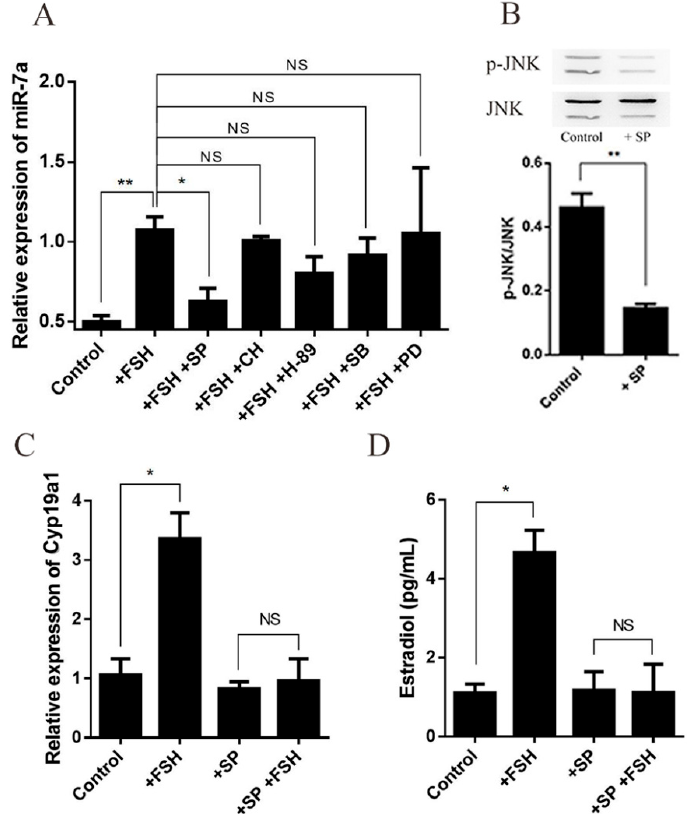
Figure 7. MiR-7a is regulated by FSH via the JNK signaling pathway in mouse granulosa cells. ( A ) MiR-7a levels in granulosa cells were determined by RT-qPCR. ( B ) Analysis of p-JNK protein in primary granulosa cells with SP (JNK inhibitor, 10 μ M). ( C ) Quantification of the Cyp19a1 expression in cells by RT-qPCR (normalized to GAPDH ). ( D ) Estimation of estrogen concentration in the cell culture medium by RIA. Data are presented as mean ± SEM ( n = 3). Significant differences are indicated by * p < 0.05, ** p < 0.01. NS, not significant.